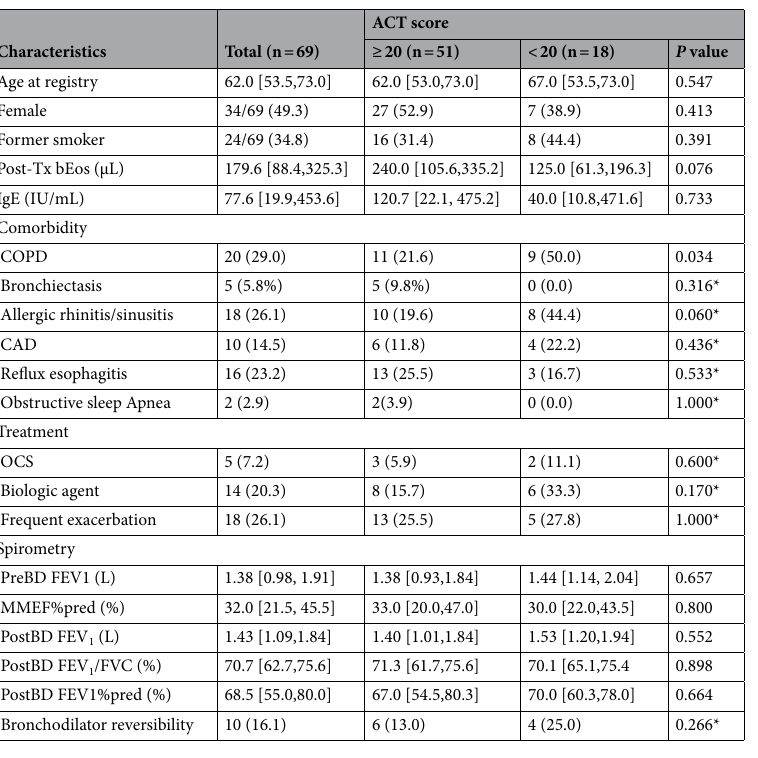
Table 1. Patient demographics and characteristics. Categorical variables are presented as frequency (percentage) and compared with poorly controlled and well-controlled asthma using Pearson’s chi-square test and Fisher’s exact test. Continuous variables did not pass the Kolmogorov–Smirnov normality test and were recorded as median [interquartile range] and used a non-parametric test with the Mann–Whitney U Test. ACT, asthma control test; AE, acute exacerbation; AR, allergic rhinitis; BMI, body mass index; Bronchodilator reversibility: positive with post-bronchodilation FEV1 change ≥ + 200 mL and change of predicted percentage ≥ + 12%; CAD, coronary artery disease; COPD, chronic obstructive pulmonary disease; CRS, chronic rhinosinusitis; FDR, frequency-dependent resistance; the difference in resistance at 5 Hz and 20 Hz; FEV 1 , forced expiratory volume in 1 s; F res , resonance frequency; FVC, forced vital capacity; IOS, impulse oscillometry; MMEF, maximal mid-expiratory flow; OCS, oral corticosteroid; Post-Tx bEos, blood eosinophil level after asthma treatment with steps 4–5 treatment. * Fisher’s exact test. **Exacerbation: Severe: Emergency visit or hospitalization; emergency, requiring systemic corticosteroids or increasing dose from baseline. Moderate: Deterioration in the patient’s symptoms or lung function beyond day-to-day variations requiring a change of medication but that does not meet severe criteria. Frequent exacerbation: severe AE ≥ 1 time/year or moderate AE ≥ 2